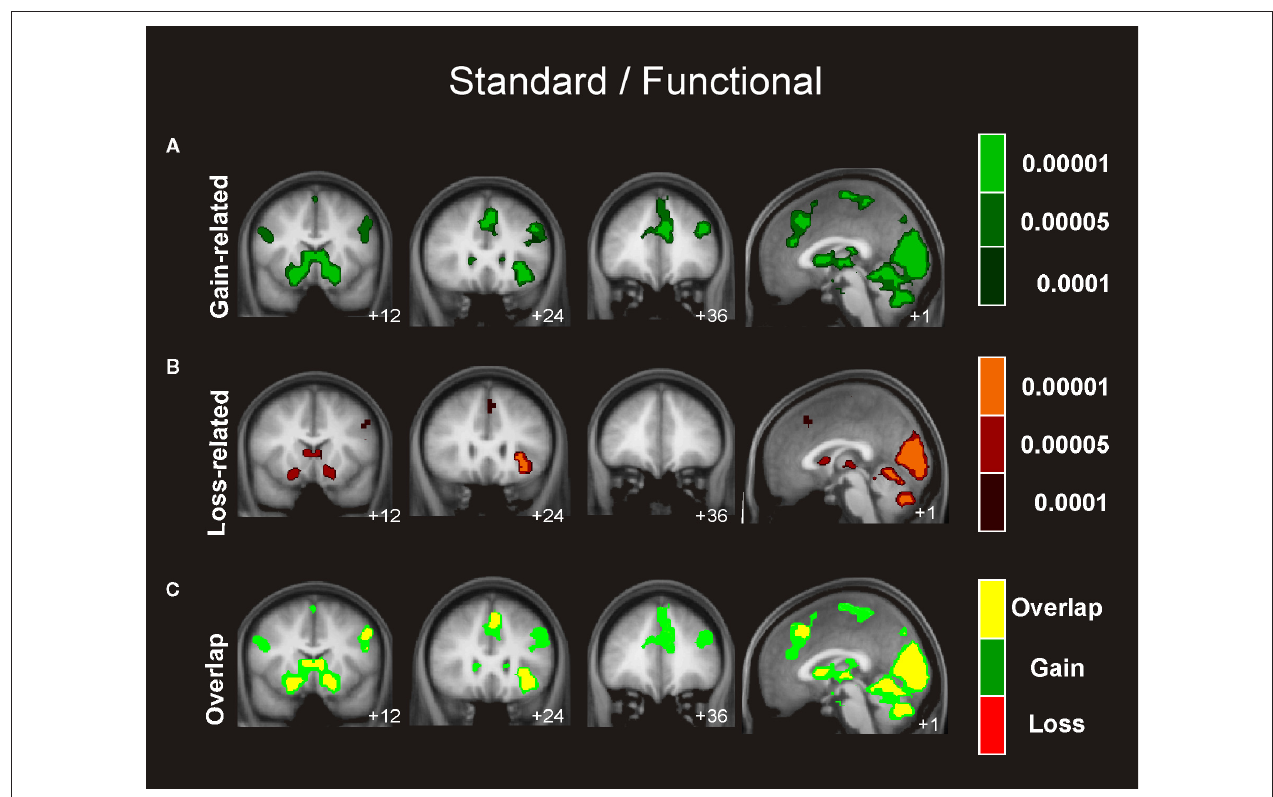
(A) and the loss vs. fi xation contrast (B) using different statistical thresholds ( P < 0.0001; P < 0.0005; P < 0.001). Gain and loss patterns are simultaneously represented in (C) : gain (green, P < 0.001), loss (red, P < 0.001), and conjunction gain (cid:2) loss (yellow, P < 0.001 and P < 0.001).